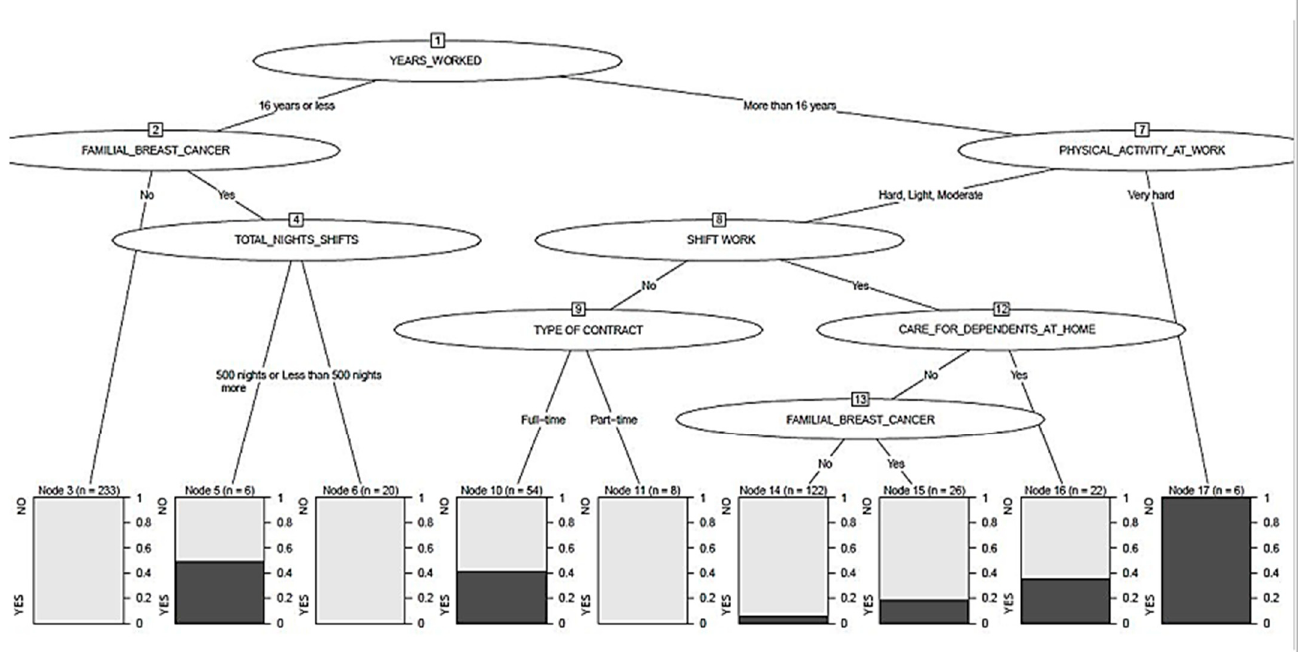
Figure 1. Segmentation tree of breast cancer and work-related factors.